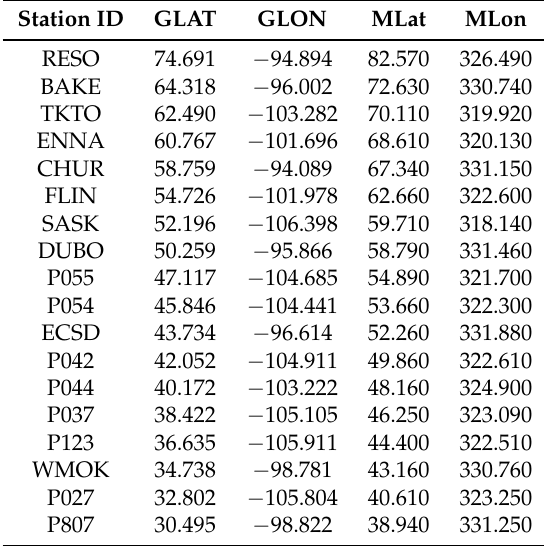
Table 2. Geographic and geomagnetic positions of the considered North-American stations (in